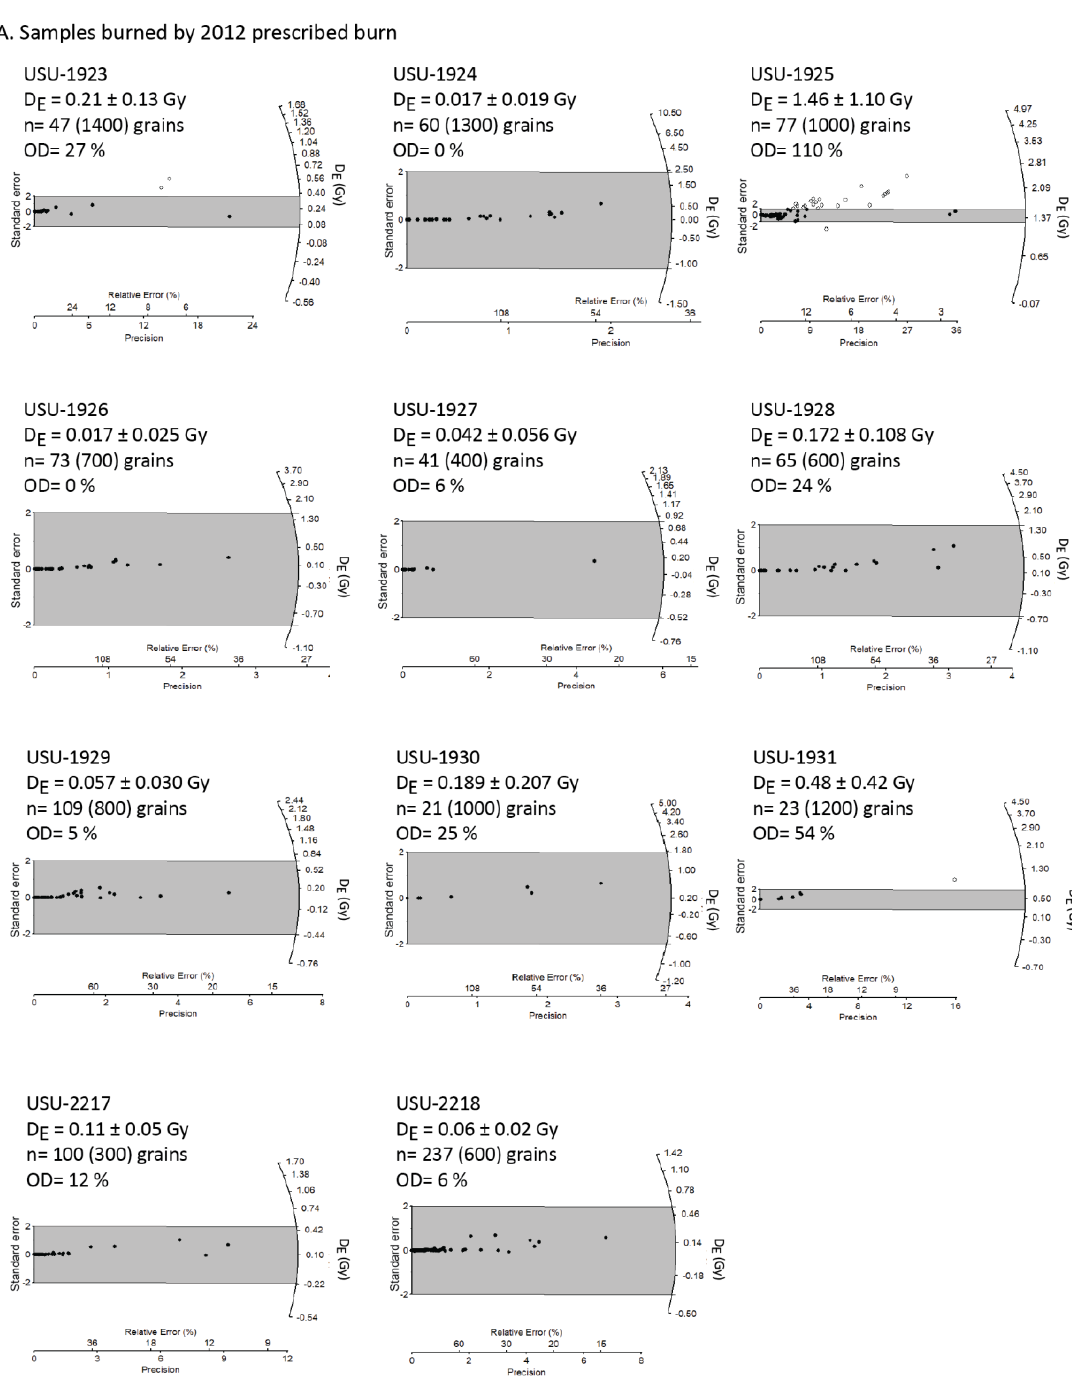
Figure A4. Radial plots of OSL measurements of ceramics from the 2012 burn area.